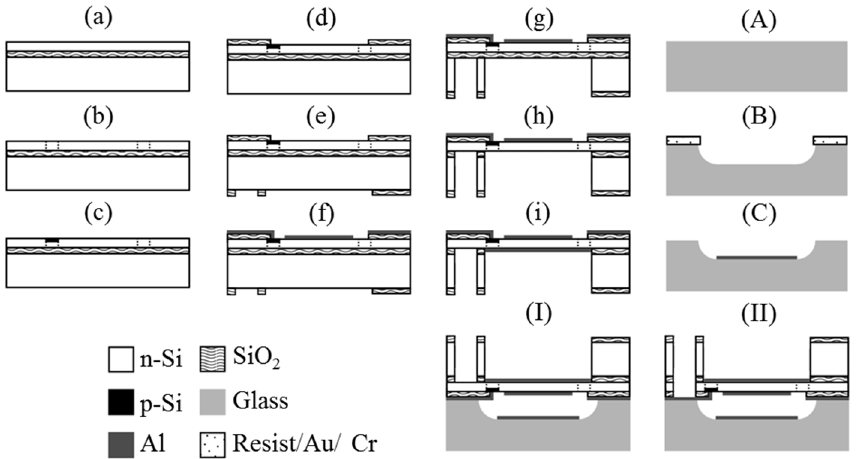
Figure 5. Process steps for the fabrication of the varifocal mirror. ( a ) SOI wafer; ( b ) Top Si etching;